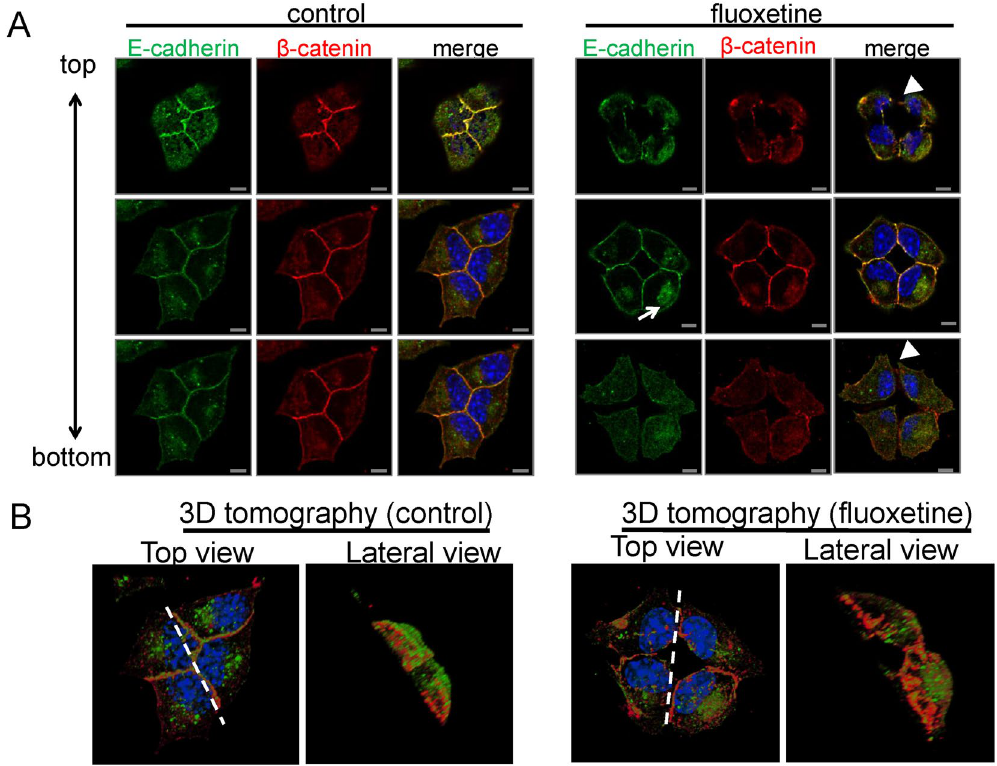
Figure 2. Fluoxetine alters the structure of adherence junction and the subcellular distribution of E-cadherin. After 3-hour treatment with or without fluoxetine (30 μ M), MIN6 cells were fixed and then immune-stained with Alexa 488 (green) for E-cadherin, Alexa 594 (red) for β -catenin and Hoechst 33258 (blue) for nucleus. The images were captured by confocal microscope (Olympus, MPE). Scale bar, 10 μ m. ( A ) Representative confocal images showing the distribution of E-cadherin and β -catenin at different z-sections. White arrowheads indicate separated cells. Arrows indicates the aggregation of E-cadherin in cytoplasm. The representative images were from at least three independent experiments. Scale bar, 5 μ m. ( B ) The 3D images of E-cadherin and β -catenin distribution were visualized by the Avizo software from at least 30 slices of confocal